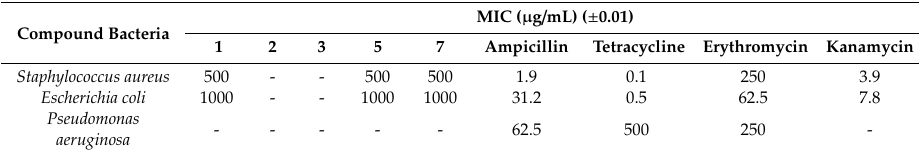
Table 6. MIC values of thiadiazole derivatives against S. aureus , E. coli , and p. aeruginosa referenced to commercially used antibiotics.